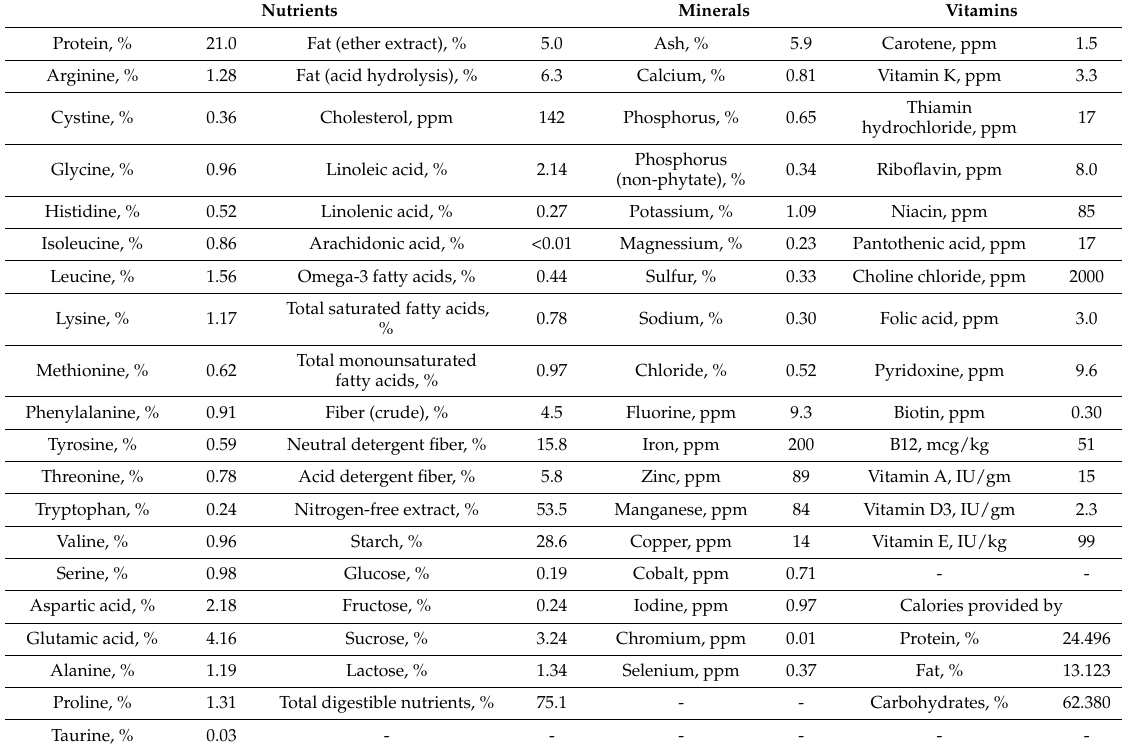
Table 1. Diet composition of the regular diet (cat# 5053, LabDiet, Brentwood, MO, USA). Nutrients Minerals